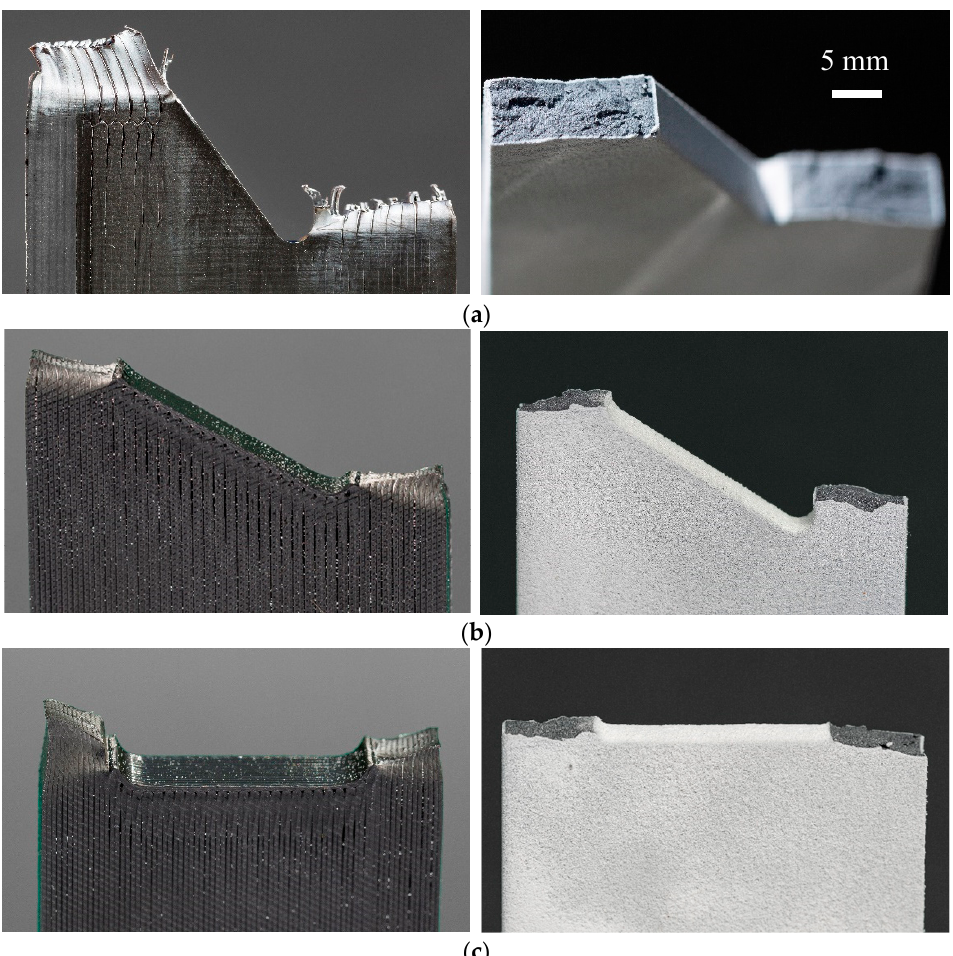
Figure 7. Close-up photographs FDM and MJF printed nylon specimens after fracture from left to right, respectively, with ( a ) 60 ° , ( b ) 30 ° , and ( c ) 0 ° notch orientations.